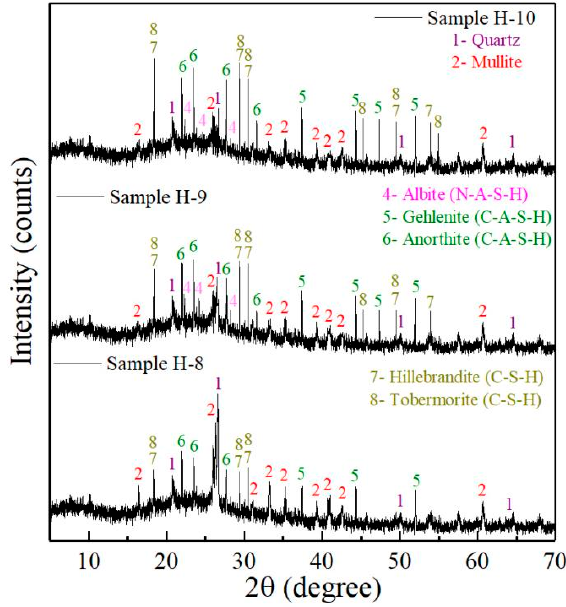
Figure 5. XRD patterns of the compound activators. (2) X-ray diffraction analysis of sample H-10